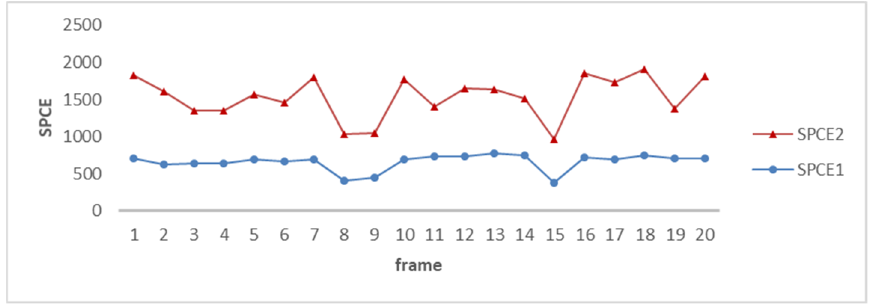
Figure 4. The values of SPCE between normal video frames and RSPN.